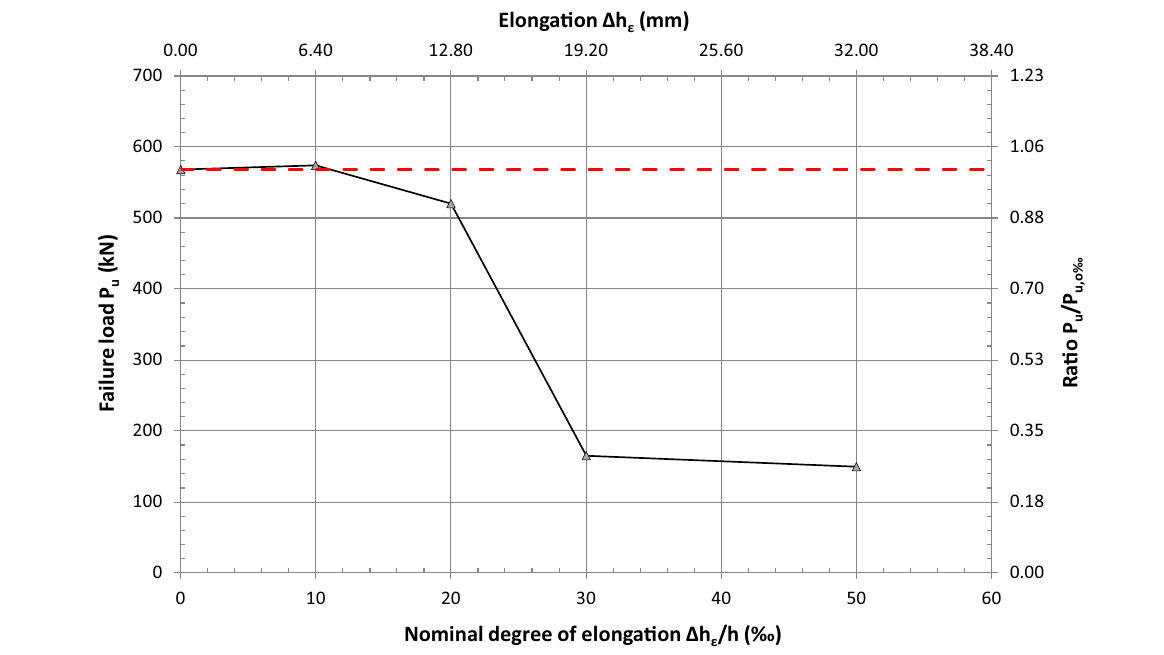
Fig. 10 Change of ultimate failure load relative to the degree of elongation.